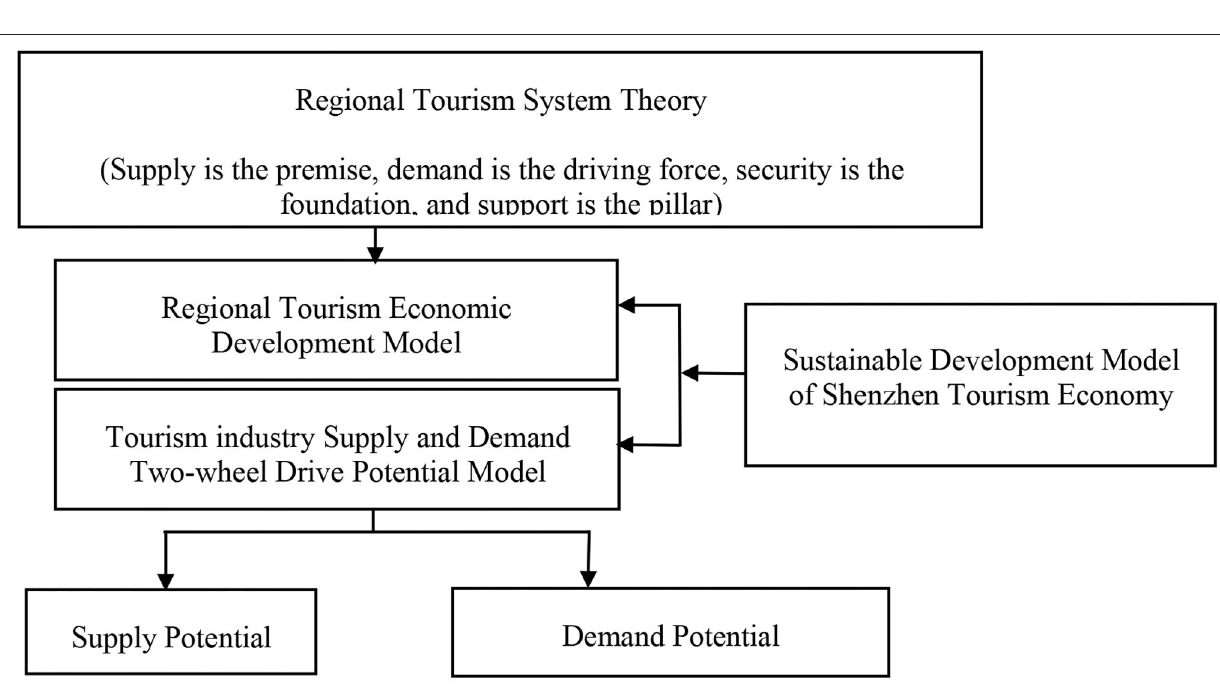
FIGURE 2 | Shenzhen tourism economic sustainable development hierarchy model design